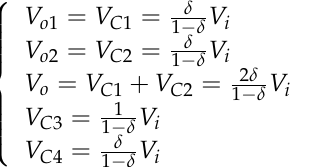
Taking into account the expressions given by (5) and (6), the converter static voltage gain of each output and capacitor voltages can be obtained, which are given by: